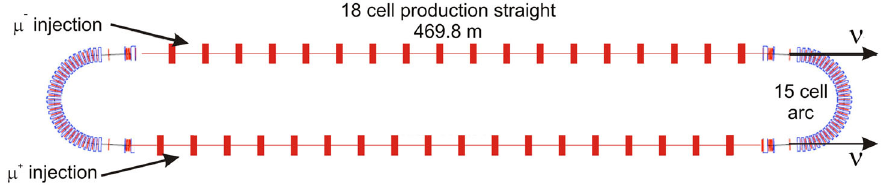
FIG. 13. Schematic of the racetrack muon decay ring.